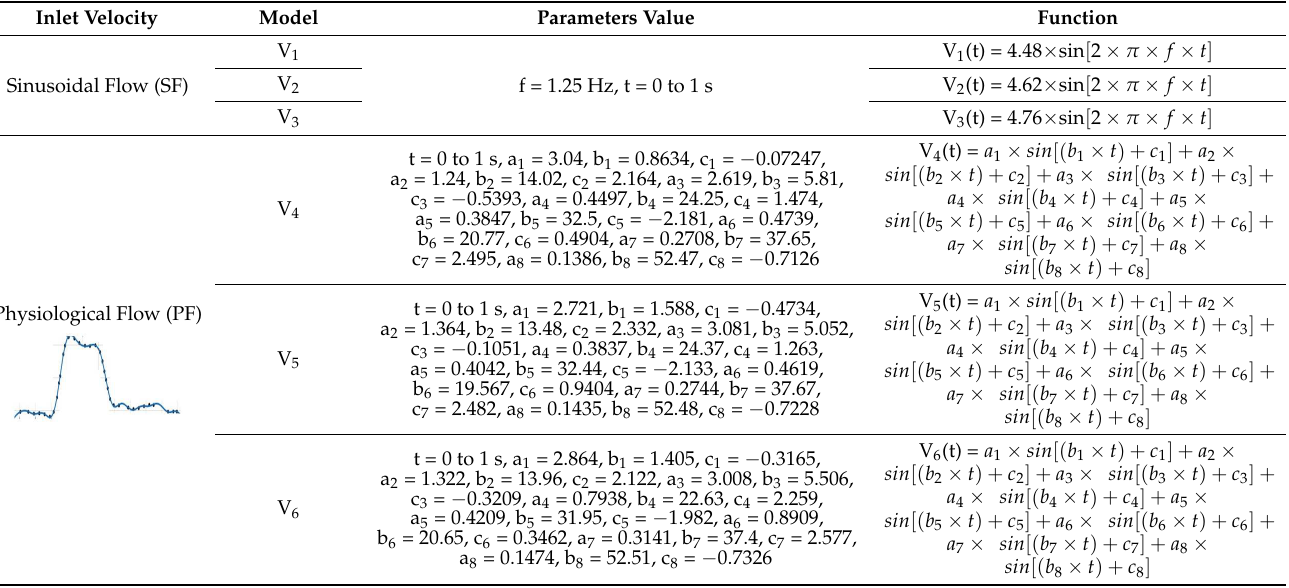
Table 2. Velocity function for V 1 to V 6 .